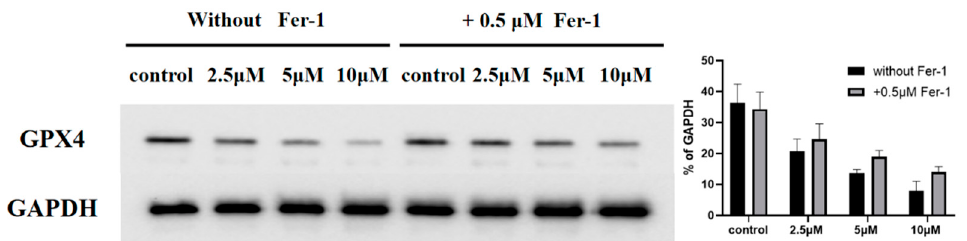
Figure 8. Effects of hybrid A8 on the expression of GPX4 in MCF-7 cells; cells were treated with 0, 2.5, 5 and 10 µ M of compound A8 for 48 h, and GAPDH was used as the internal control.